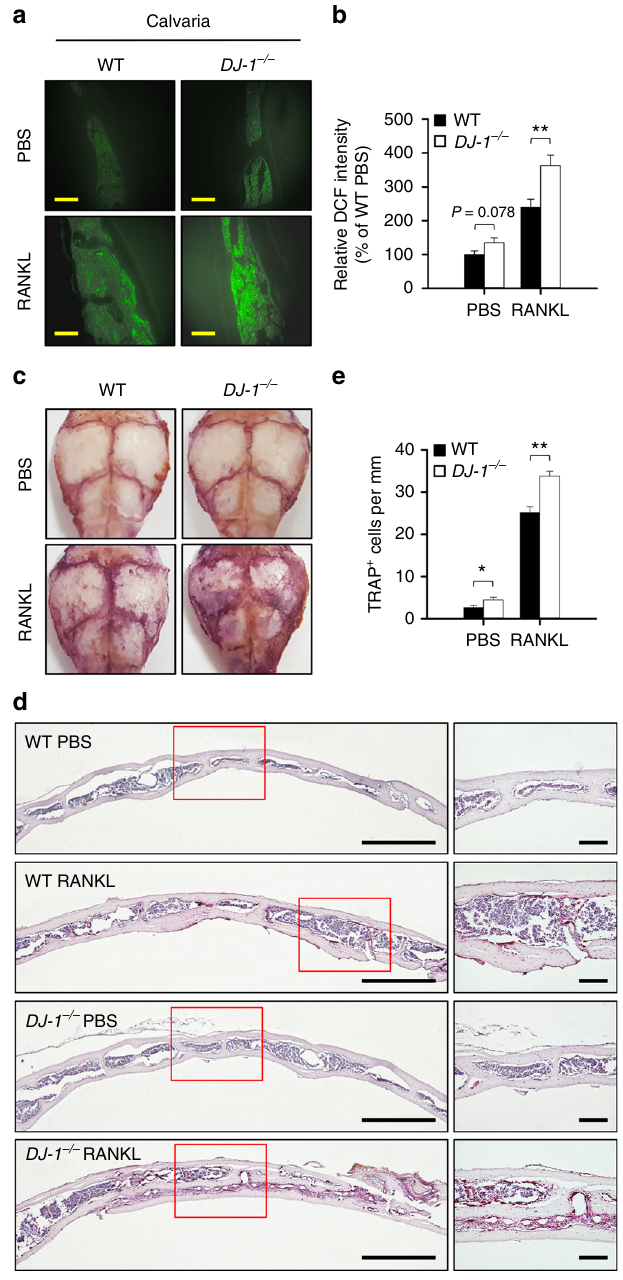
Fig. 6 DJ-1 de fi ciency increases ROS and OC number in mice. a Representative images for DCF fl uorescence and b relative DCF intensities in RANKL-stimulated calvaria in WT and DJ-1 − / − mice. Scale bar, 100 μ m. c – e Representative images for TRAP-stained whole c and sectioned d calvaria tissues in RANKL-treated WT and DJ-1 − / − mice. Scale bar, 500 μ m (left), 100 μ m (right). e Number of TRAP + cells in cavaria tissues in RANKL-injected WT and DJ-1 − / − mice. Representative images a , c , d or the mean ± s.e.m. b , e are shown. n = 6 per group. ** p < 0.01, * p < 0.05 by Student ’ s t